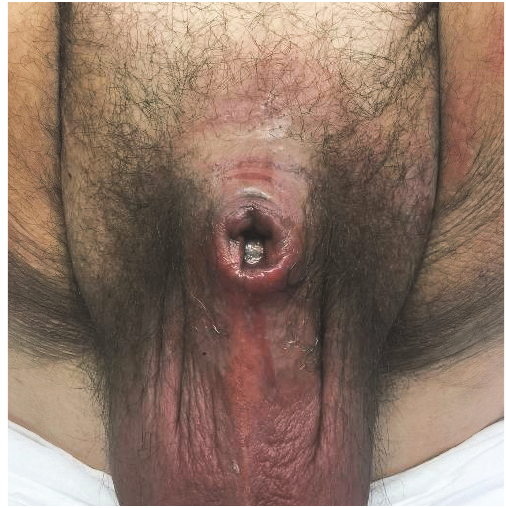
Figure 1: Initial examination revealing phimosis with purulent drainage.